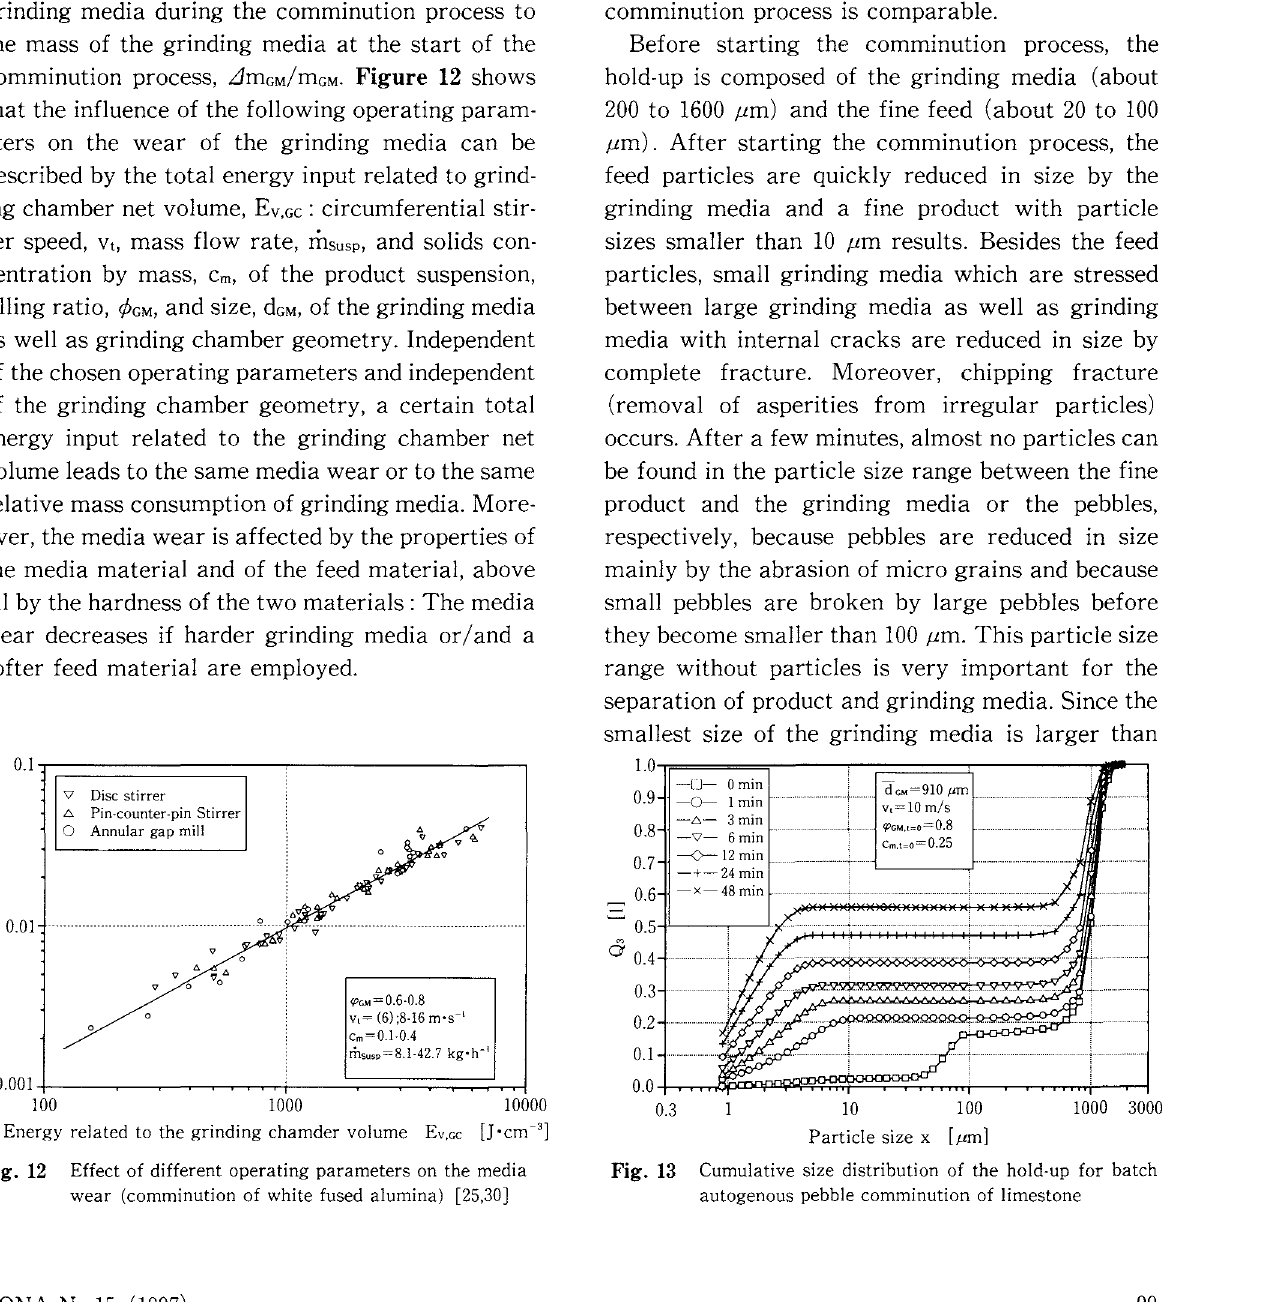
KONA No.l5 (1997)